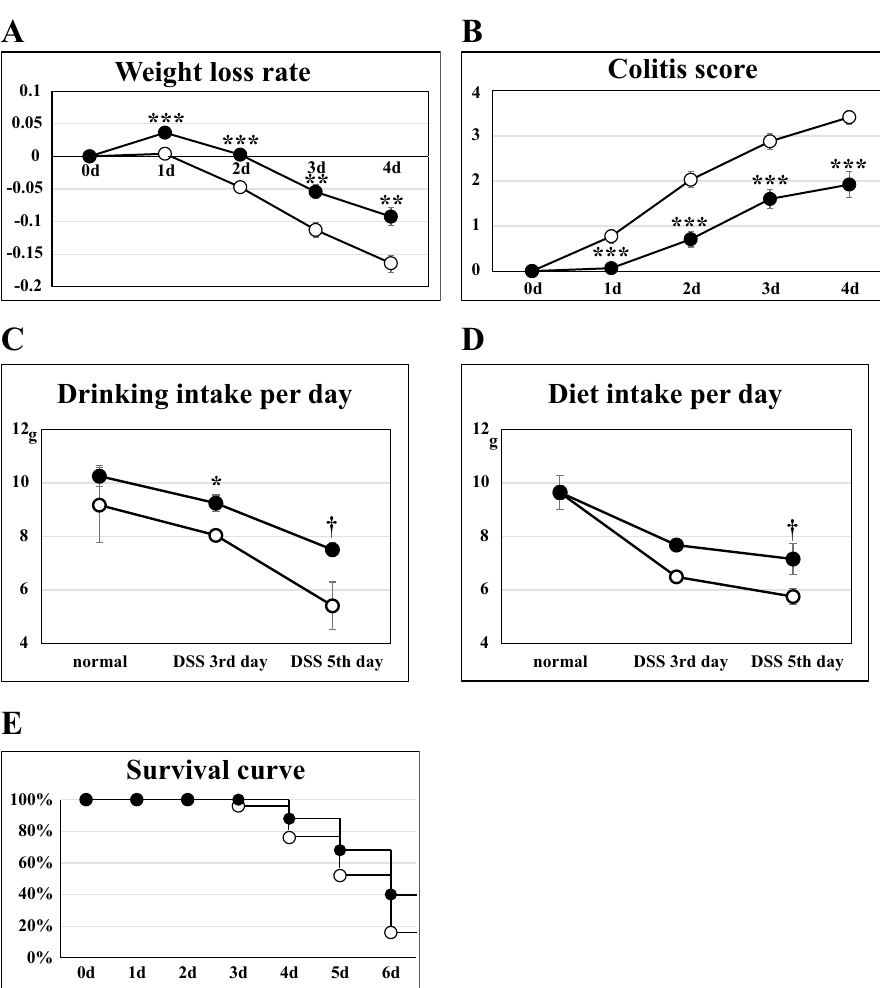
Figure 1. Si-based agent alleviated the symptoms of UC. Time-dependent changes in the gross pathology, the intake of drinking and diet consumed per day, and survival rates of 5% DSS-treated mice. Line chart of weight loss rate ( A ), colitis score ( B ), the intake of drinking ( C ) and diet ( D ) consumed per day, and survival curve ( E ). White: Con-DSS group. Black: Si-DSS group. Each day of the horizontal axis is post-DSS dosing ( A , B , E ). Each diet treatment for a week (normal), DSS treatment for 3 days (DSS 3rd day) or 5 days (DSS 5th day) after each diet treatment for a week ( C , D ). Data are expressed as mean ± SEM of 25 mice ( A , B , D ), 4 cages ( C , D : normal; 3 mice per cage) and 3 cages ( C , D : DSS 3rd and 5th days) per group. † p < 0.09, ** p < 0.01, *** p < 0.001 vs. Con-